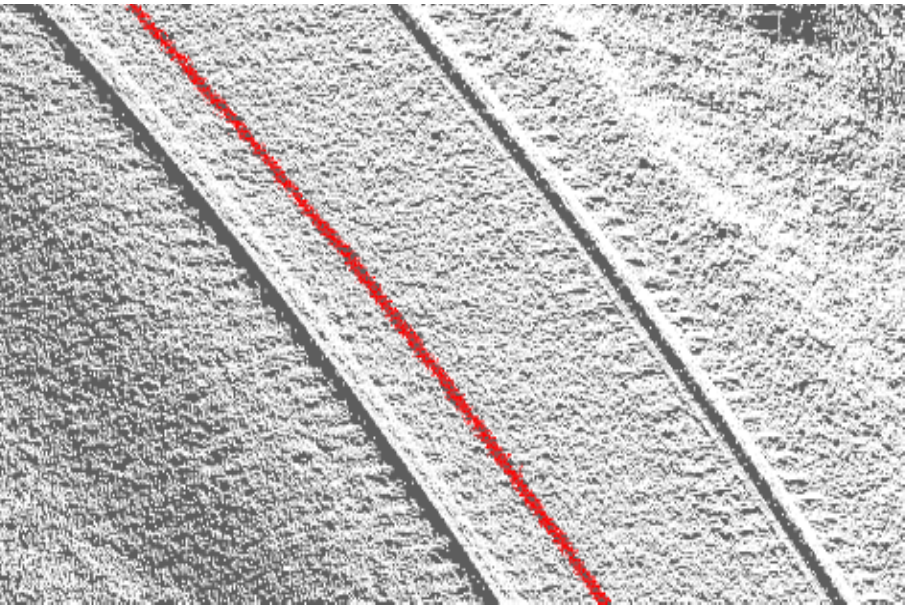
Figure 4. Point cloud just with the 0 scan angle value points coloured in red.